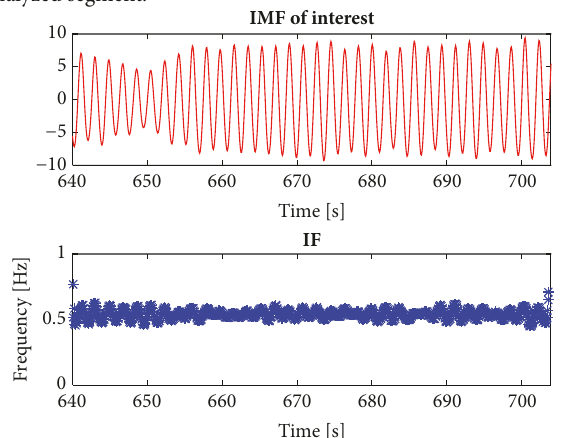
Figure 28: IMF 4 linked to BWR instability and its associated IF (very close to 0.5 Hz).